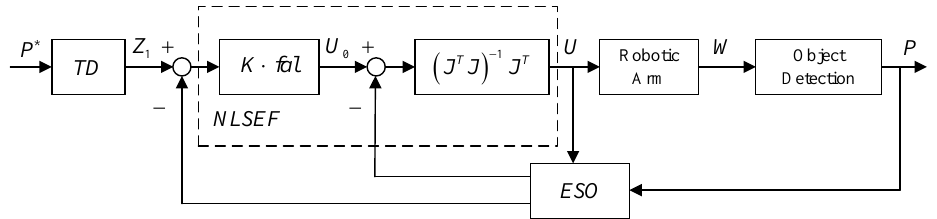
Figure 4. Control system block diagram